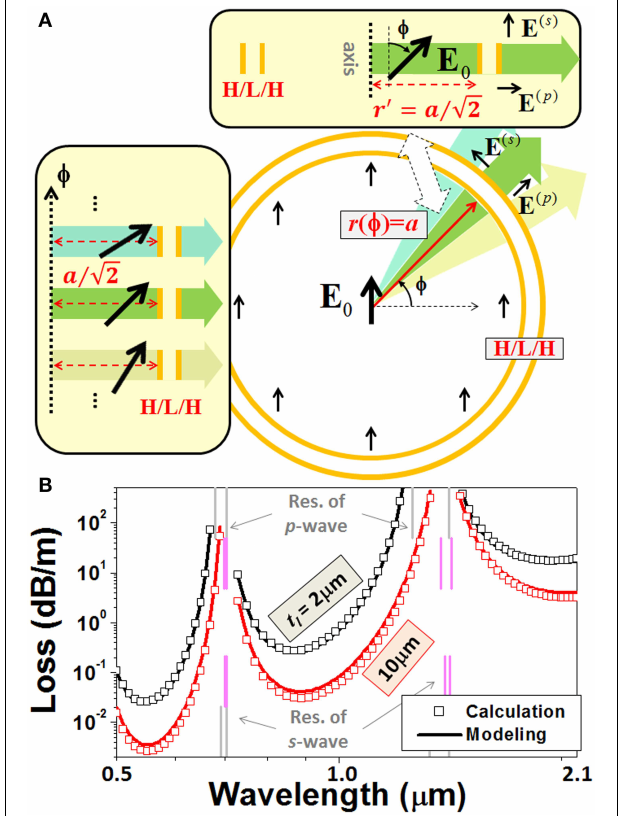
FIGURE 8 | (A) Geometry transformations from a circular ARF having an H/L/H core-surround to a series of slab waveguides. The core-surround structures in the fiber and in the slab are identical. (B) Precisely calculated (the hollow squares) and semi-analytically modeled (the solid lines) attenuations of the fiber for the thickness of the low-index layer, t l , to be 2 µ m or 10 µ m. a 15 µ m, and t h 0.67 µ =